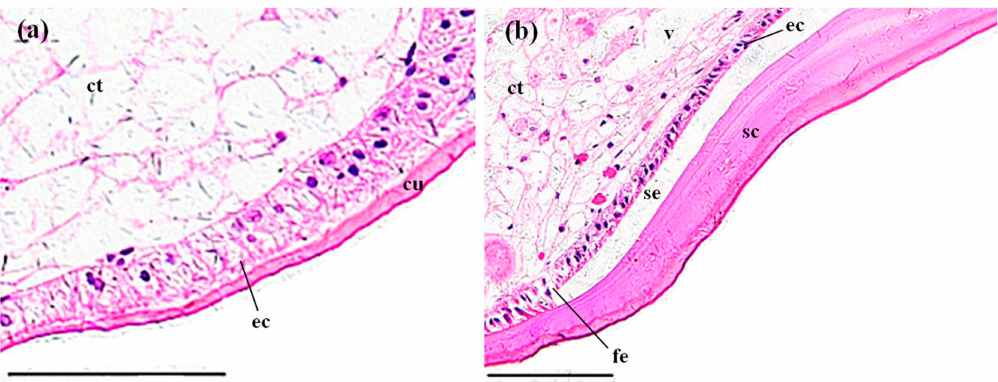
Figure 5. The stomachs of P. clarkii after 96 h exposure to: A control solution and 72.62 mg/L MBA. ( a ) Control stomachs showed normal cuticula (cu), epithelial cells (ec) and connective tissues (ct) with clear and uniform structure (200 × ). ( b ) Damaged stomachs exhibited swelling of the cuticula (sc), fragmentation of the epithelial layer (fe), separation of the epithelial layer from the cuticula (se) and some vacuolization of the connective tissues (v) (200 × ). ec, epithelial cell. H&E stain, scale bars = 100 µ m.